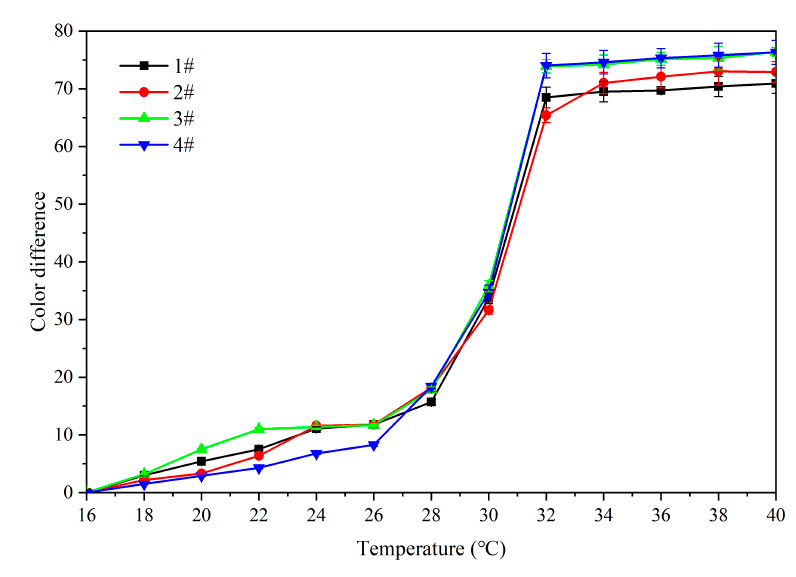
Figure 8. E ff ect of temperature increase (16–40 ◦ C) on color di ff erence of primer film added Figure 8. Effect of temperature increase (16–40 °C) on color difference of primer film added with with microcapsules. microcapsules.